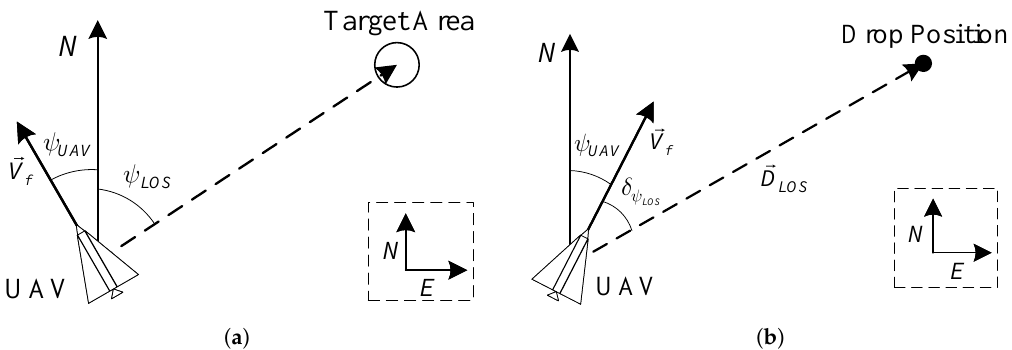
Figure 3. Problems Description among UAV Airdrop Task: ( a ) the UAV should turn its nose towards target area firstly; ( b ) after adjustment of azimuth, the UAV could follow the guidance of UAV maneuver decision-making policy until reaching target